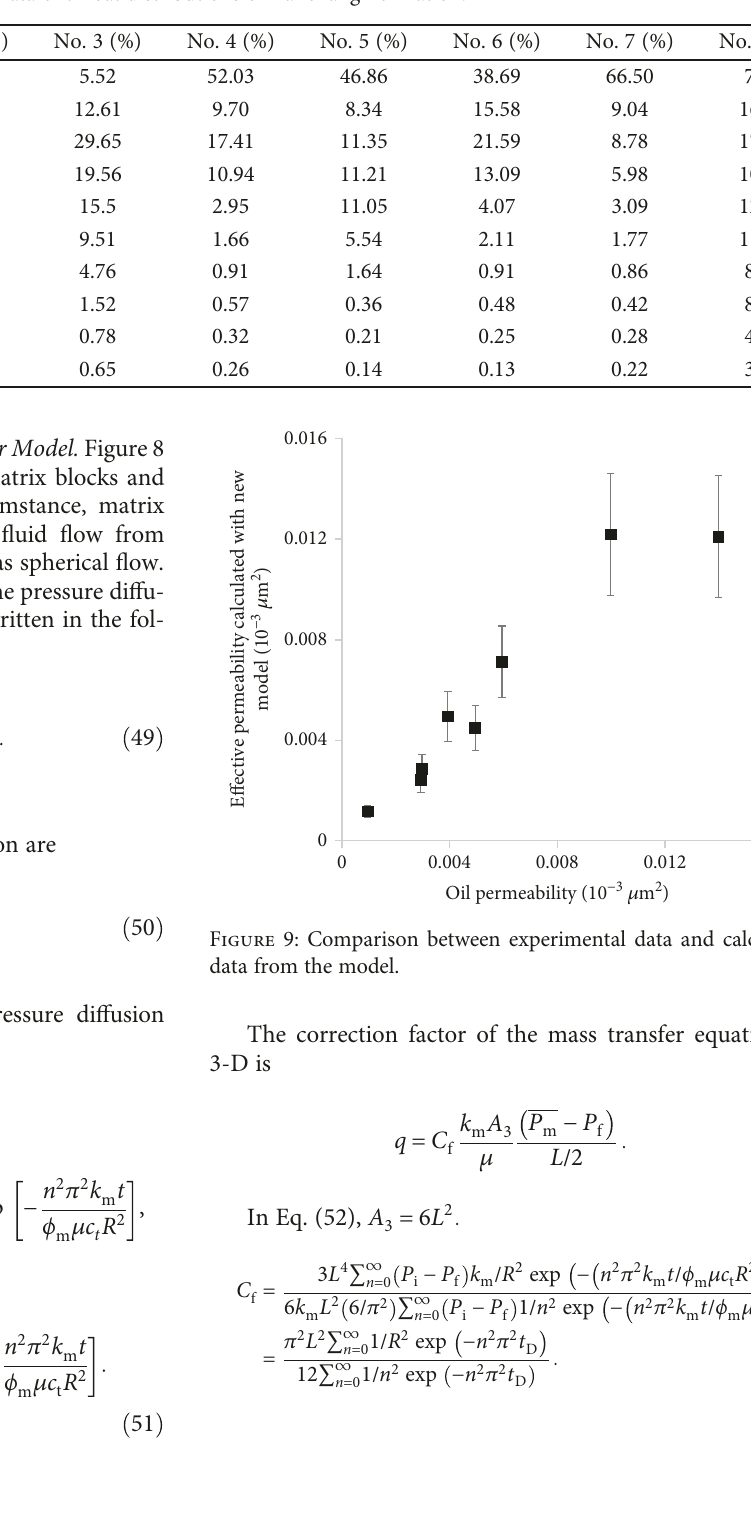
Table 2: Data of throat distributions of Yanchang Formation.